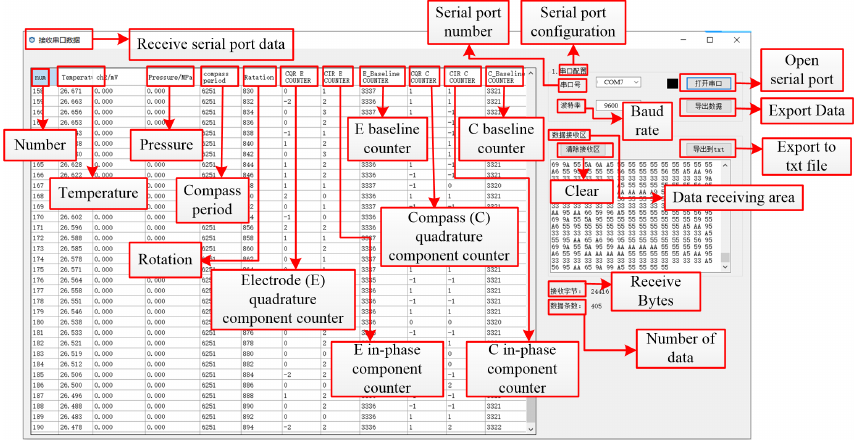
Figure 10. The interface of the serial port receiving data.